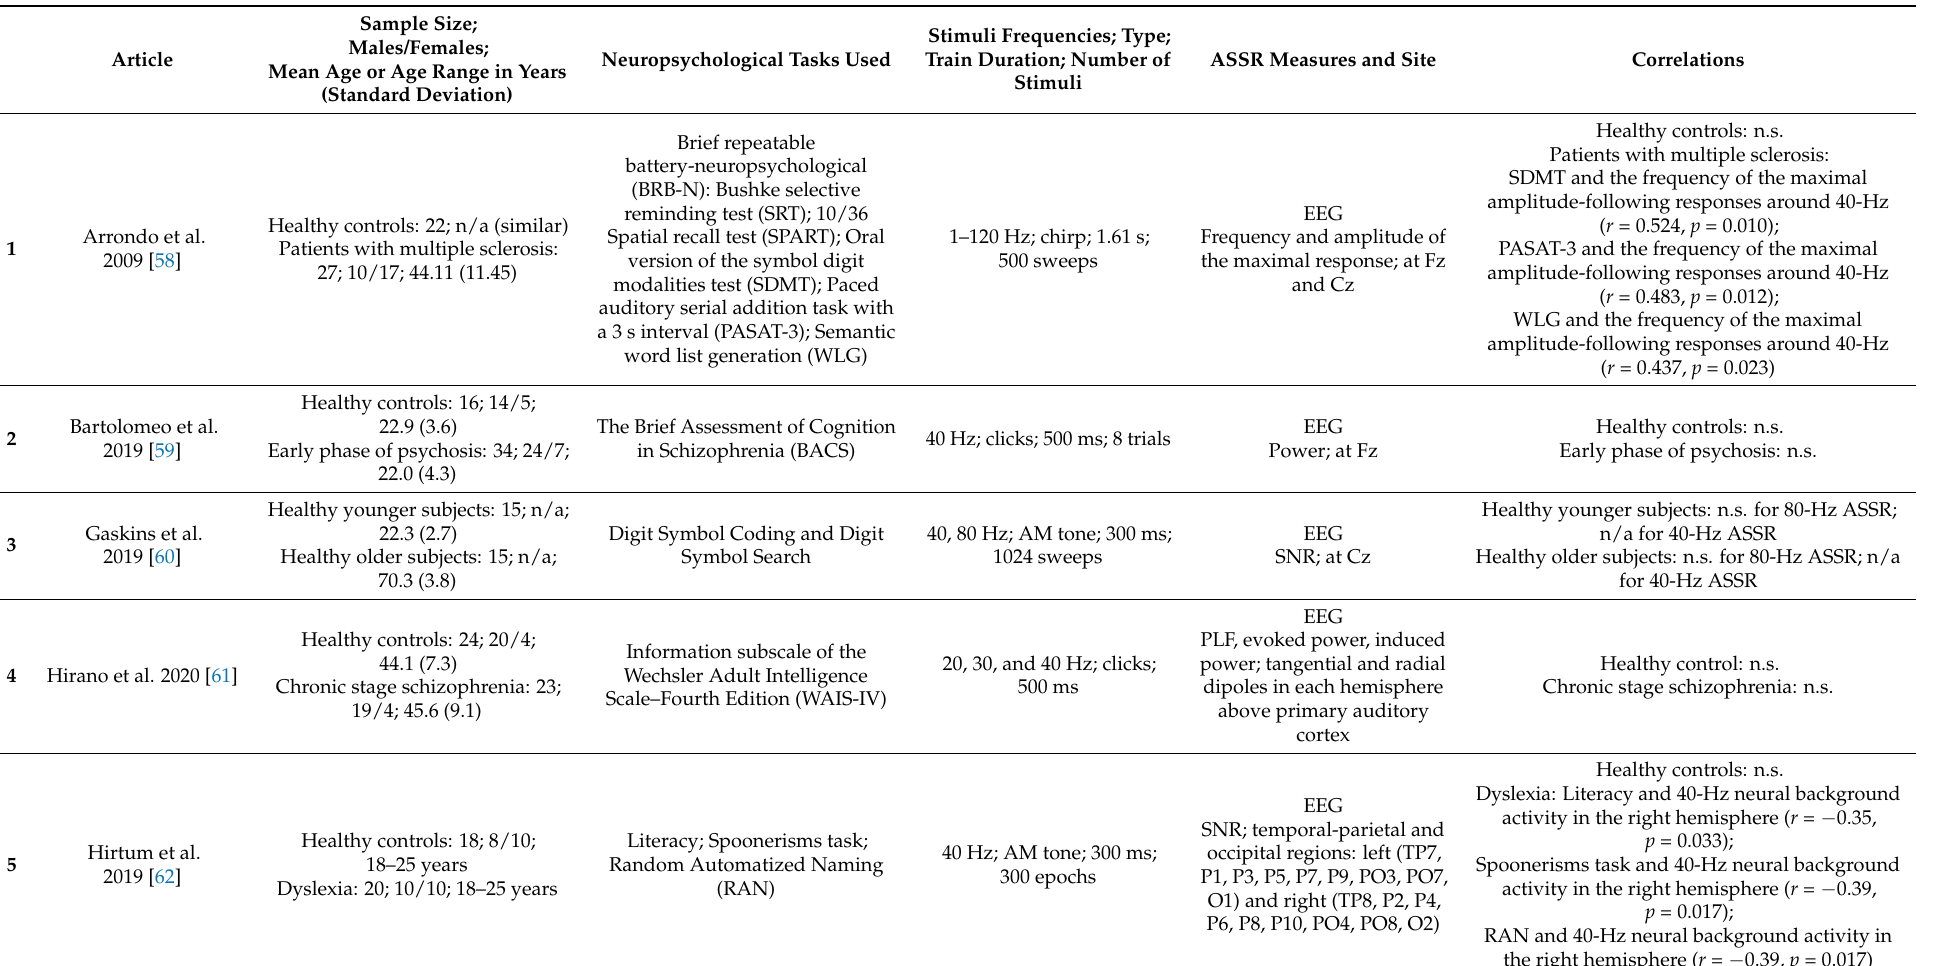
Table 1. Characteristics of the studies included in the